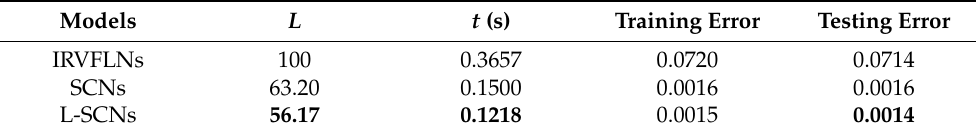
Table 3. Performance comparison of highly nonlinear